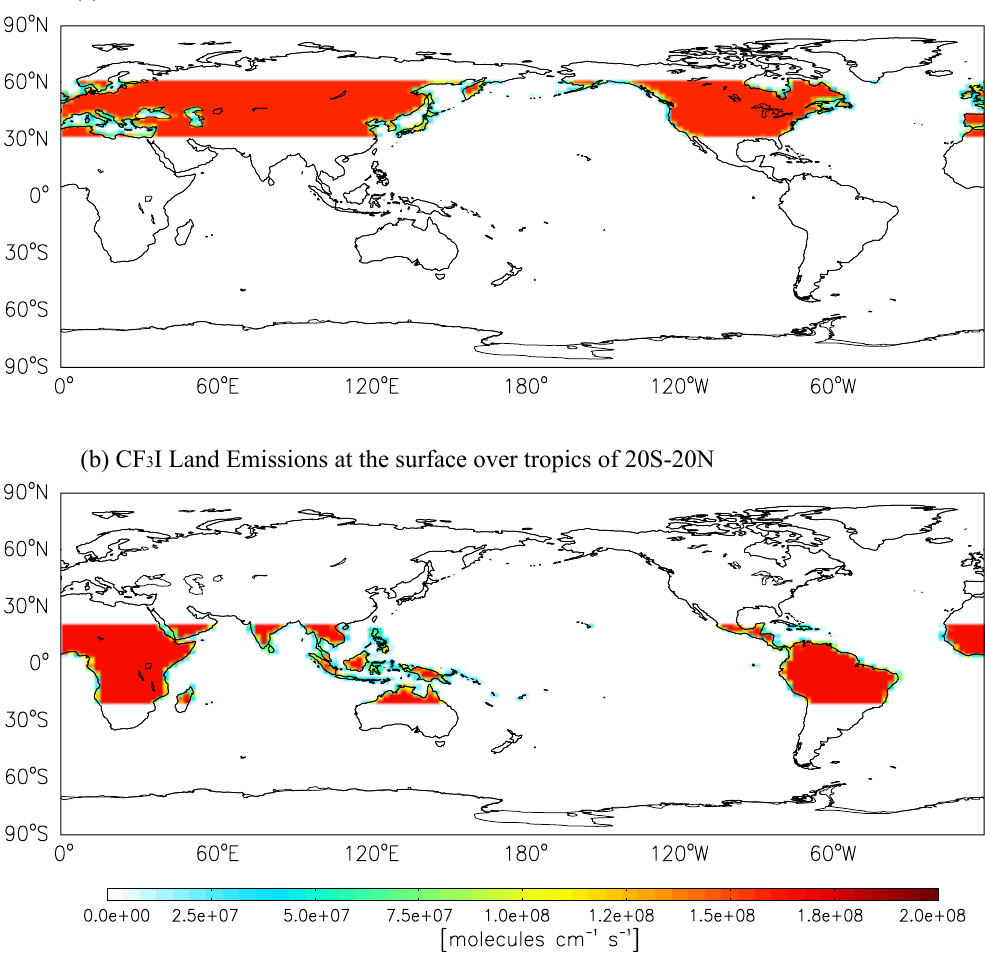
Fig. 1. Land-based surface emission fluxes of CF 3 I over (a) 30 ◦ N to 60 ◦ N and (b) 20 ◦ S to 20 ◦ N in the unit of moleculescm − 1 s − 1 . These postulated emissions are inputs to model perturbation runs. The surface flux is adjusted at boundary grids considering actual land